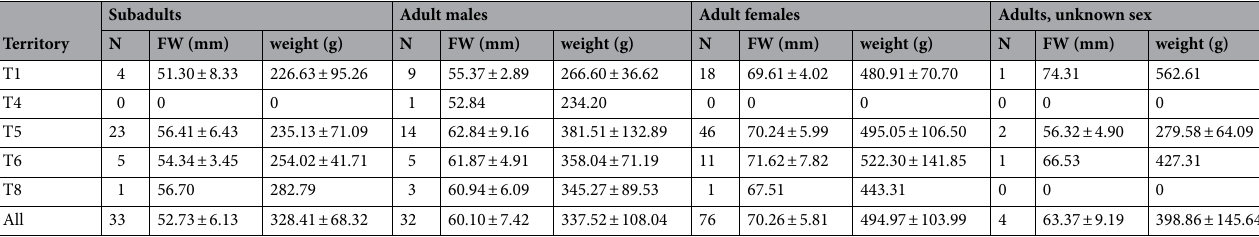
Table 1. Size (FW = width of femoral scutes) and biomass (total weight, including the shell) of the spur- thighed tortoises predated by golden eagles in SE Spain, according to eagles’ territories with tortoise remains.